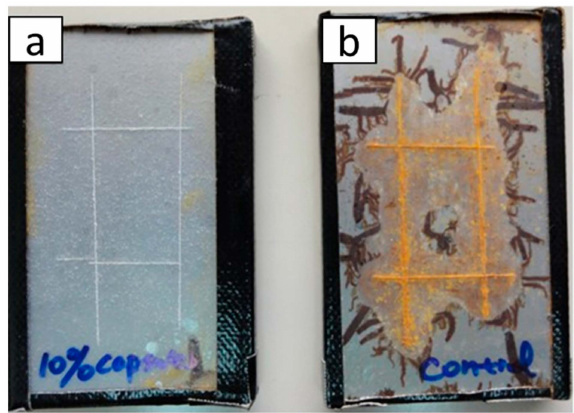
Figure 7. Photographs of steel panel coated with ( a ) 10 wt.% hexamethylene diisocyanate (HDI) microcapsule incorporated coating and ( b ) pure coating after accelerated salt immersion test for two days followed by storage at room temperature for six months. Adapted from [62], with permission from © 2014 Elsevier.